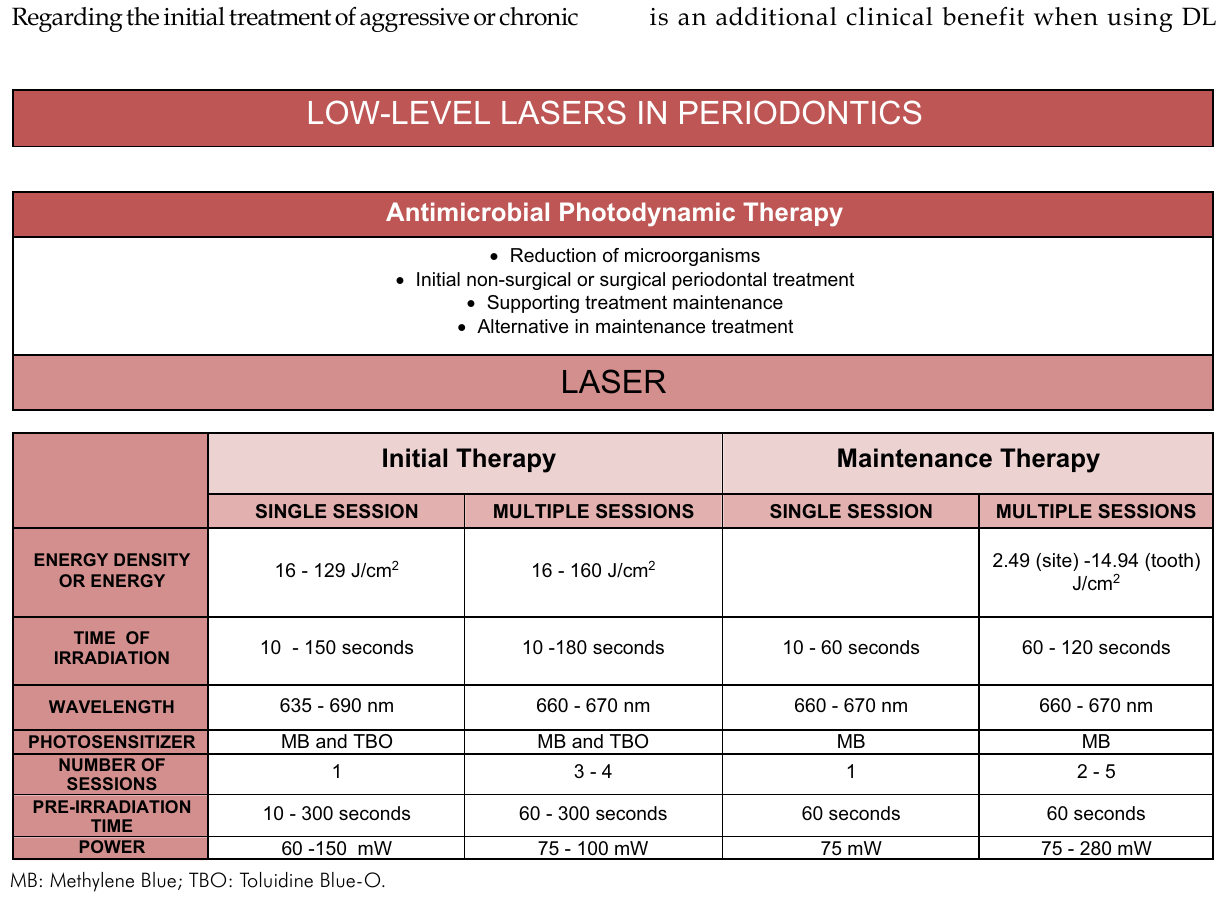
Figure 3. Indications and irradiation parameters of the low-level lasers in APDT described in the periodontal